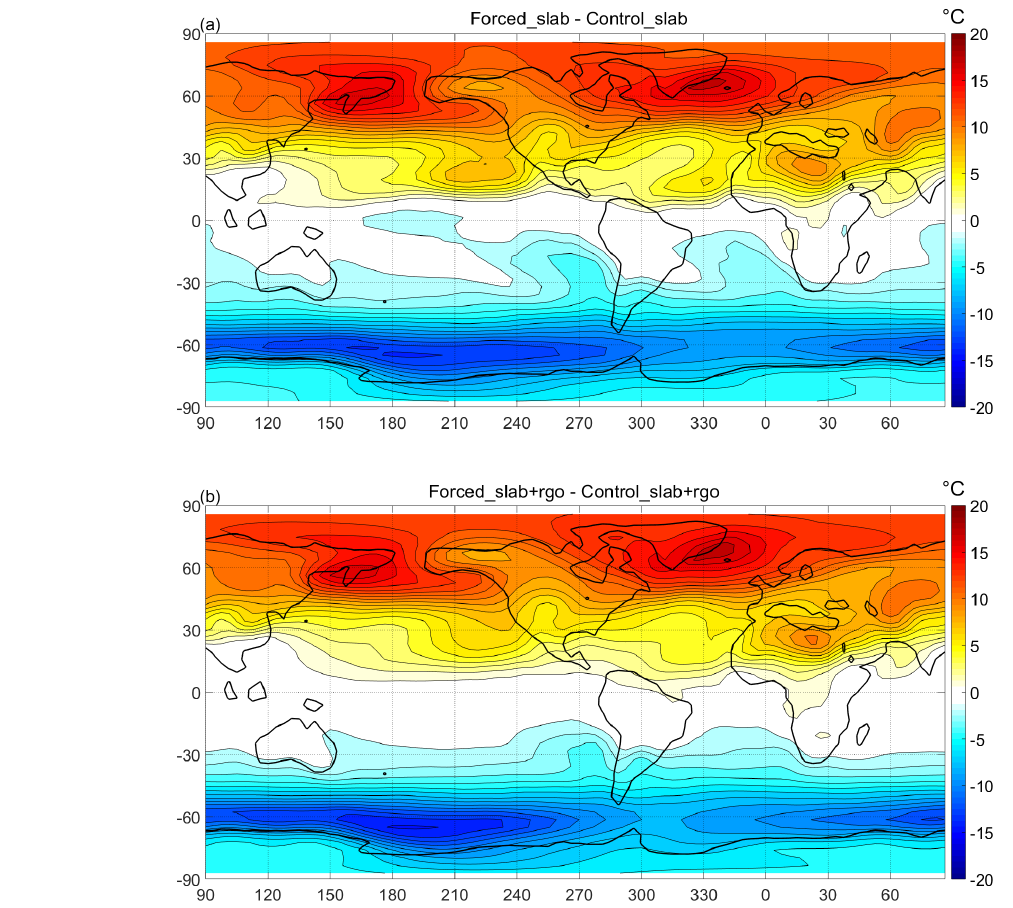
Figure 4. Annual mean anomalies with respect to the control of NSAT for (a) Forced_slab and (b) Forced_slab + rgo . Contour interval 1 ◦